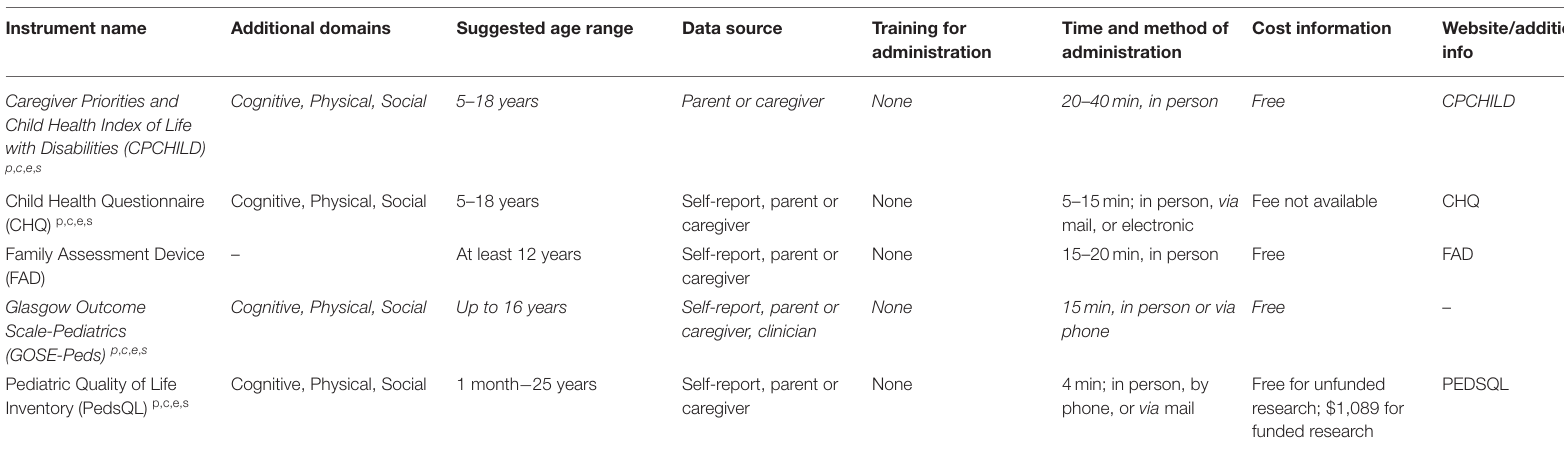
TABLE 7 | Family functioning and child quality of